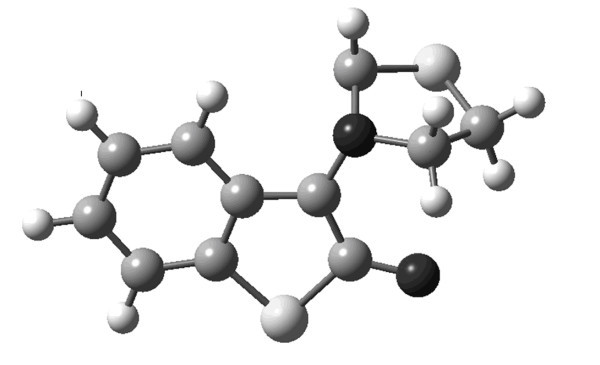
Optimized geometry of amy 4anti.